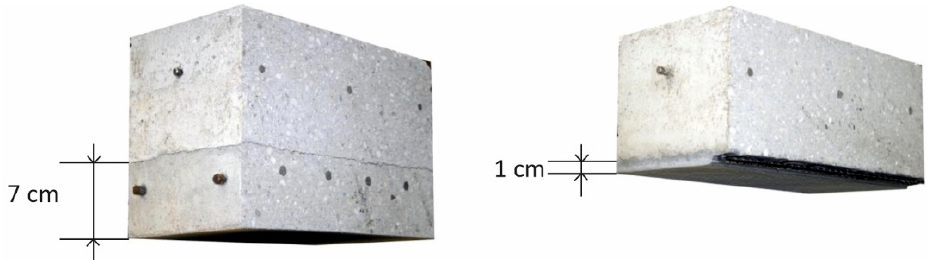
Figure 1. Comparison between the thickness of a shotcrete strengthening ( left ) and strengthening with carbon reinforced concrete ( right ) with the same load-bearing capacity. (Photo: TU Dresden).